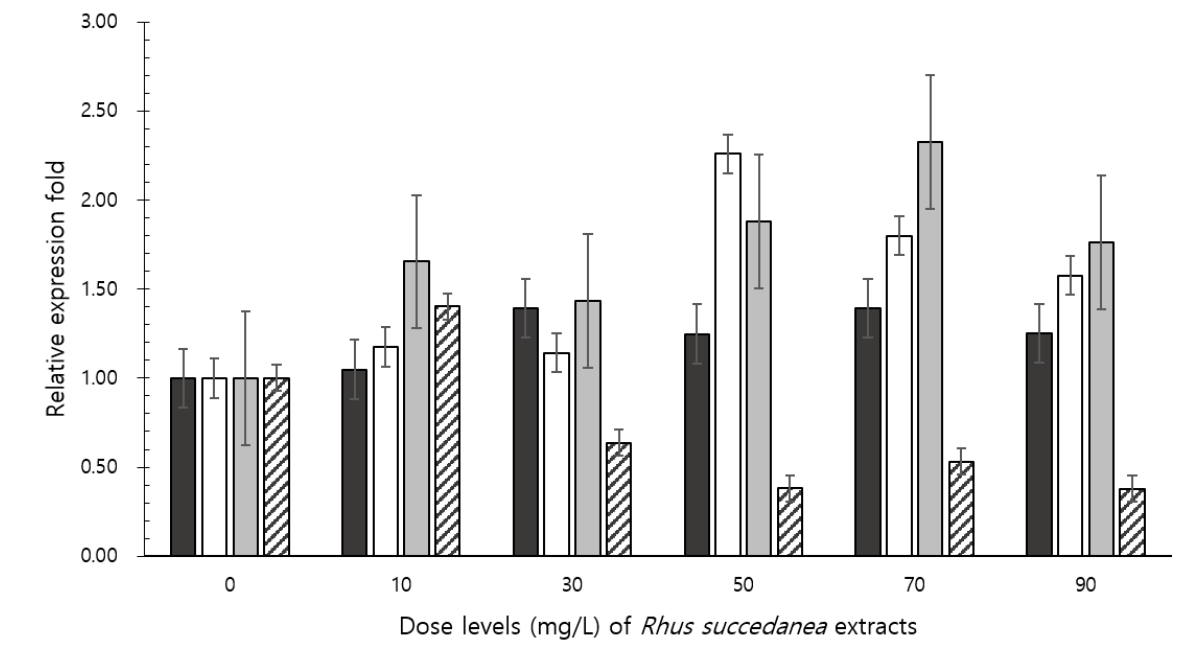
Figure 2. Relative quantification of in vitro rumen microbial populations at 24 h incubation by different doses of Rhus succedanea extracts. Ruminococcus albus (black bar), Fibrobacter succinogenes (white bar), Ruminococcus flavefaciens (grey bar), and methanogenic archaea (hatched bar). Error bars are standard error of the